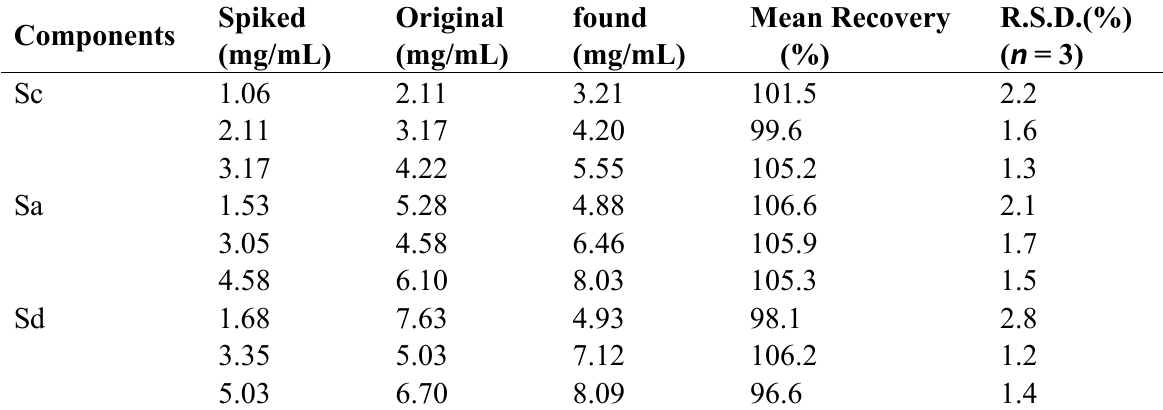
Table 2. Recovery test of the three saikosaponins in B. falcatum ( n =